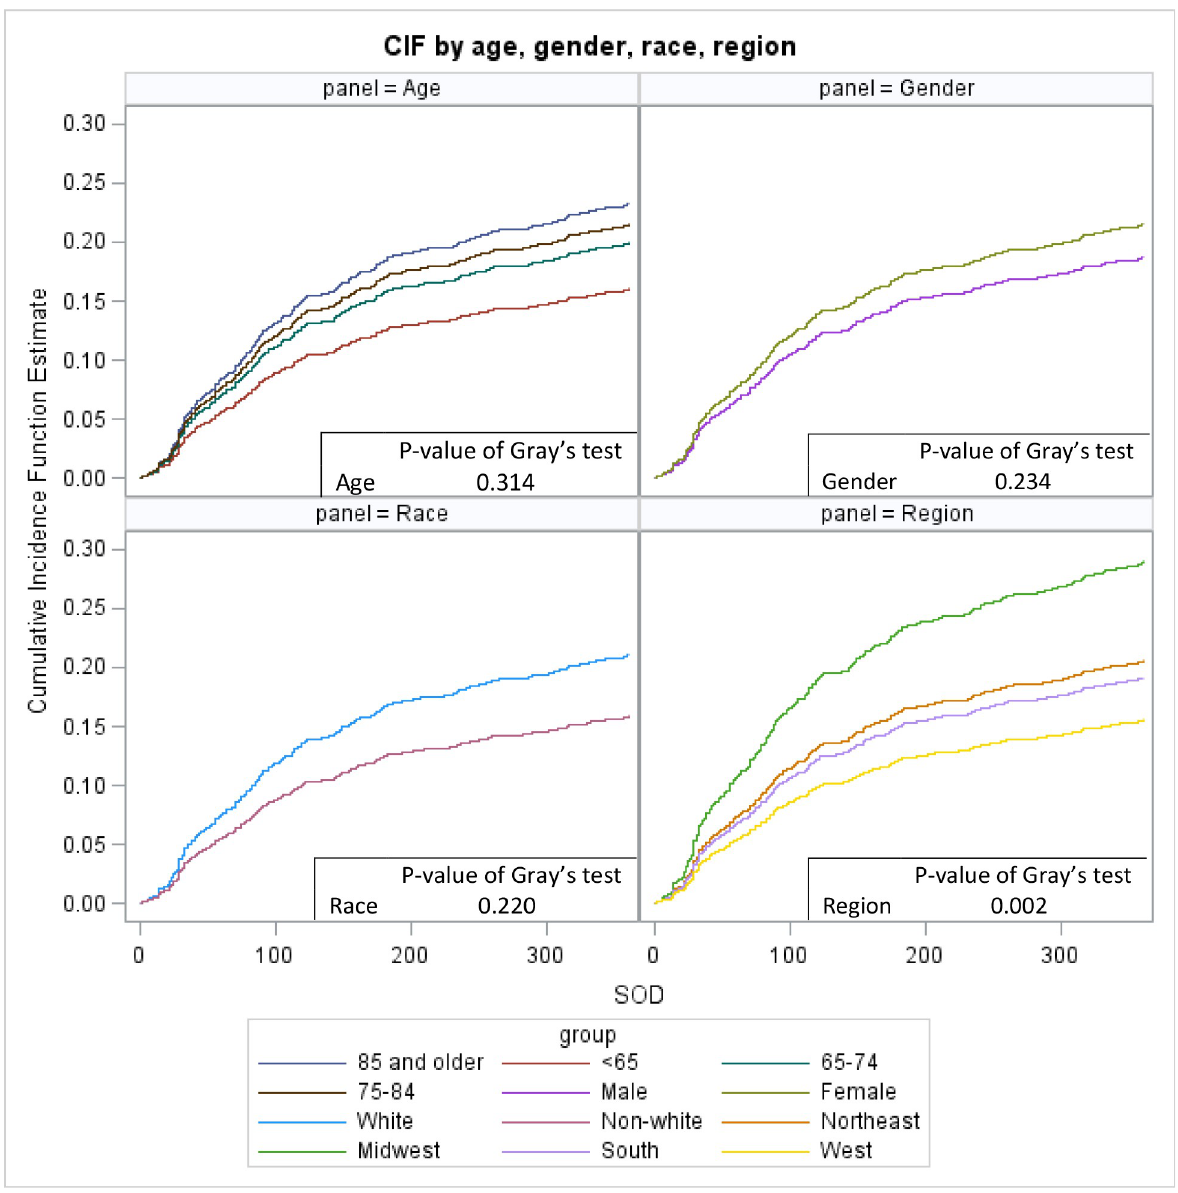
Fig 3. Cumulative incidence function plots for time to generic substitution within 12 months by different patient subgroups (age, sex, race and region) among Medicare beneficiaries who initiated brand escitalopram treatment (n = 1,464).